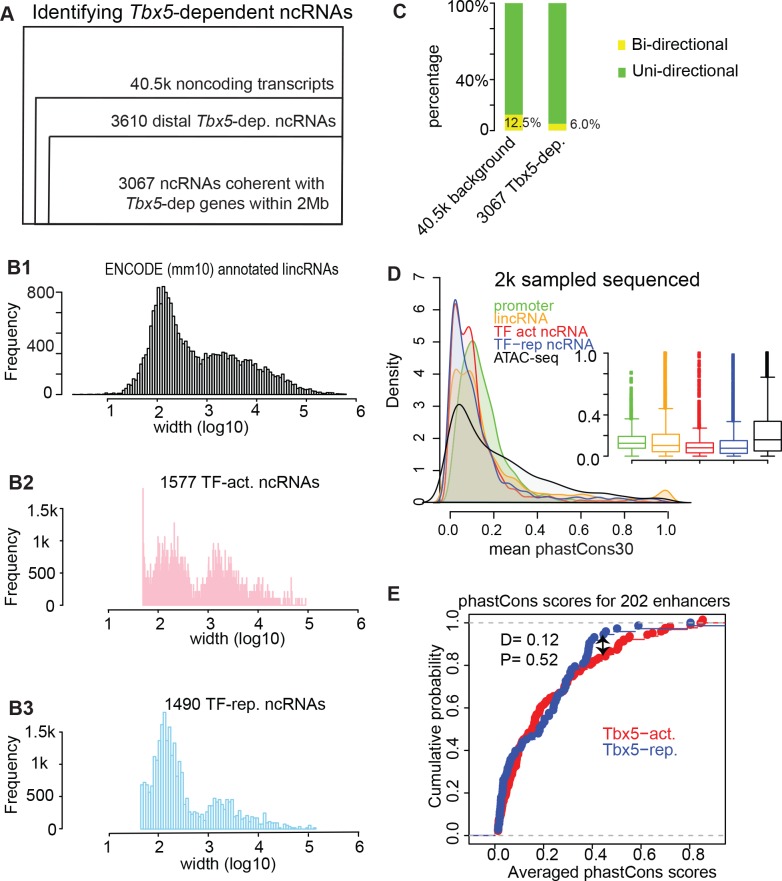
Genomic features of the identified TF-dependent ncRNAs recapitulate known features of annotated lincRNAs.(A) Pie chart showing the composition for the identified TBX5-dependent ncRNAs using de novo assembly (Cufflinks). The 3067 ncRNAs were categorized into six groups. GENCODE (mm10)-annotated ncRNAs with relatively few instances were grouped together as ‘predicted ncRNAs’. De novo indicates a previously unannotated noncoding transcript. (B) Histogram distribution of the ncRNA width on log10 scale. The distribution of GENCODE annotated lincRNAs (B1), the identified TF-activated ncRNAs (B2), and the TF-repressed ncRNAs (B3) are shown. (C) Stacked bar-graphs showing percentage of unidirectional (green) and bi-directional (yellow) noncoding transcripts among the total noncoding transcript calls, the Tbx5-activated ncRNAs, and the Tbx5-repressed ncRNAs. (D) Histograms and boxplots of average phastCons30 sequence conservation scores for promoter regions (green), GENCODE annotated lincRNAs (yellow), TBX5-activated and TBX5-repressed ncRNAS (red and blue, respectively), and ATAC-Seq (black). (E) Two-sample Kolmogorov–Smirnov statistics. The cumulative probabilities exhibit no difference in conservation between Tbx5-activated and Tbx5-repressed cis-regulatory elements (red and blue lines, respectively).